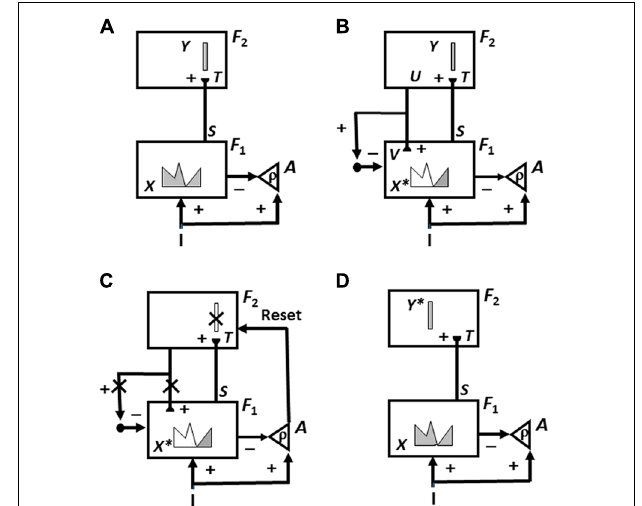
FIGURE 7 | Cycles of ART memory search and category learning using the ART Matching Rule. ART searches for and learns a new recognition category using cycles of match-induced resonance and mismatch-induced reset. Active cells are shaded gray; inhibited cells are not shaded. (A) Input pattern I is instated across feature detectors at level F 1 as an activity pattern X , at the same time that it generates excitatory signals to the orienting system A with a gain ρ that is called the vigilance parameter. Activity pattern X generates inhibitory signals to the orienting system A as it generates a bottom-up input pattern S to the category level F 2 . A dynamic balance within A between excitatory inputs from I and inhibitory inputs from S keeps A quiet. The bottom-up signals in S are multiplied by learned adaptive weights to form the input pattern T to F 2 . The inputs T are contrast-enhanced and